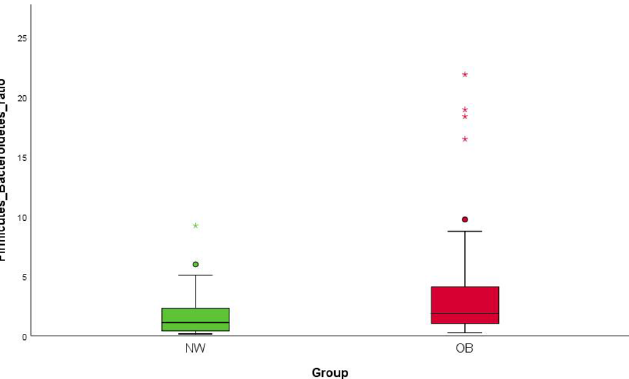
Figure 2. Statistically significant differences in Firmicutes/Bacteroidetes ratio between NW and OB. The statistical significance was calculated by the non- parametric Mann–Whitney test in R software v.3.5.2. Plots were generated in R software v.3.5.2 (ggplot2 package). The Firmicutes/Bacteroidetes ratio was significantly higher in OB, with a value more than twice that of NW ( p = 0.007; M ± SD: 4.05 ± 5.26 in OB, M ± SD: 1.75 ± 1.82 in NW). p value equal to or less than 0.05 was considered statistically significant. NW = normal-weight healthy controls, OB = overweight and obese